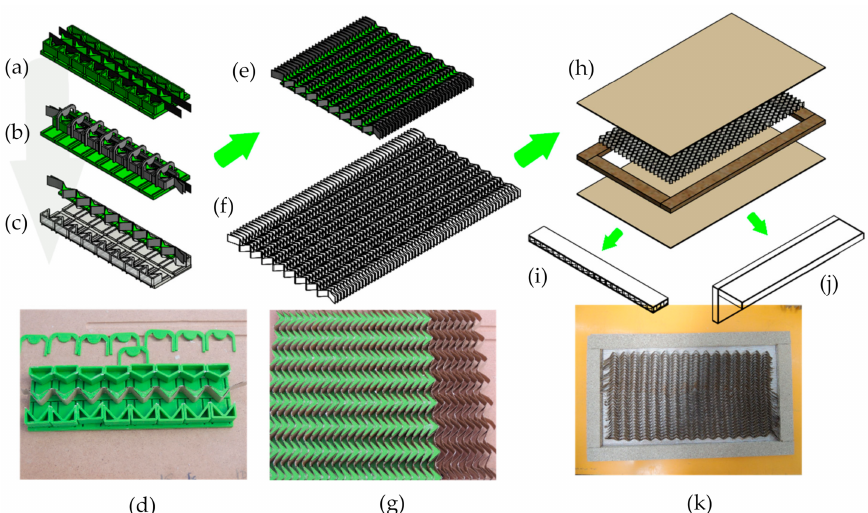
Figure 4. Honeycomb panels preparation method: paper strips were dragged along the designed and 3D printed device ( a ), then pressed successively by molds with simultaneous application of glue ( b ) to obtain a single slat with a row of core cells ( c , d ); then, 30 cell systems prepared in this way were glued in order to achieve the width of half of the assumed core dimension ( e , g ); after repeating the whole procedure, a paper core of the required dimensions of approximately 420 × 230 mm 2 ( f ) was obtained; then the cores (auxetic and reference) were embedded in 11.7 mm ( k ) particleboard frames, covered with 2.5 mm HDF facings, and the sets ( h ) were pressed (p = 1 daN / cm 2 , t = 10 min, T = 20 ◦ C); approximately 100 panels were produced in this way—with auxetic and hexagonal reference cores, from which beams for three-point bending ( i ) and elements of corner joints ( j ) were cut